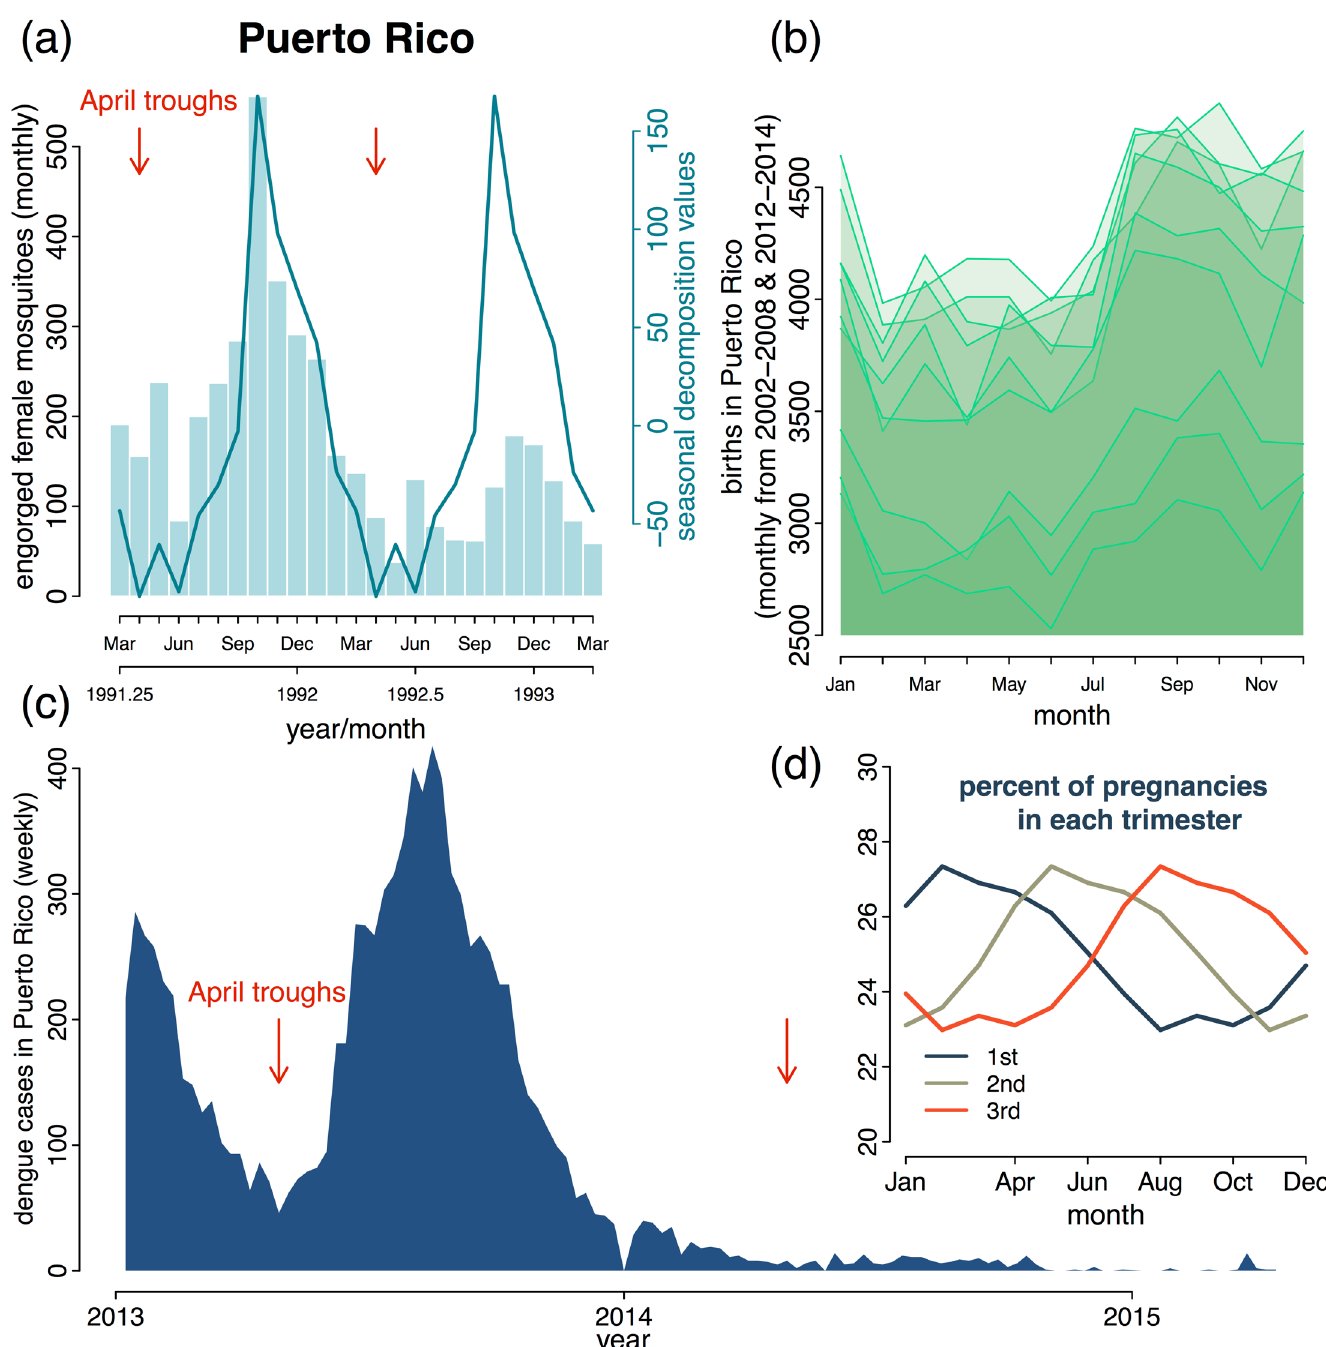
Fig 1. Seasonality of the ZIKV vector and birth seasonality. (a) Monthly abundance of trapped female mosquitoes engorged with blood-meal in Puerto Rico. Data from [36], available in S1 Data and S4 Data. Mosquitoes were collected from 20 houses in heavily urbanized areas around San Juan Metropolitan area using battery-powered aspirators. Seasonal time series decomposition was used to extract the seasonal component of the time series (solid line). Red arrows indicate the inferred seasonal trough of engorged female mosquitoes, which occurred around April each year. (b) Monthly births in Puerto Rico for the years 2002 – 2008 and 2012 – 2014. Data from [37], available in S2 Data and S4 Data. Time series from each year are stacked, with each line representing data from a single year. Births are seasonal around the world; the birth peak in Puerto Rico occurs around September each year. (c) Weekly reported DENV cases in Puerto Rico. Data are from [38], available in S3 Data and S4 Data. Red arrows indicate the inferred DENV transmission trough in April, which coincides with the trough in mosquitoes. (d) The seasonal distribution of pregnancies by trimester. The seasonal distribution of pregnancies by trimester was estimated based on the birth data from Puerto Rico. S4 Data is an R-programming package containing a function for calculating the seasonal distribution of pregnancies by trimester.